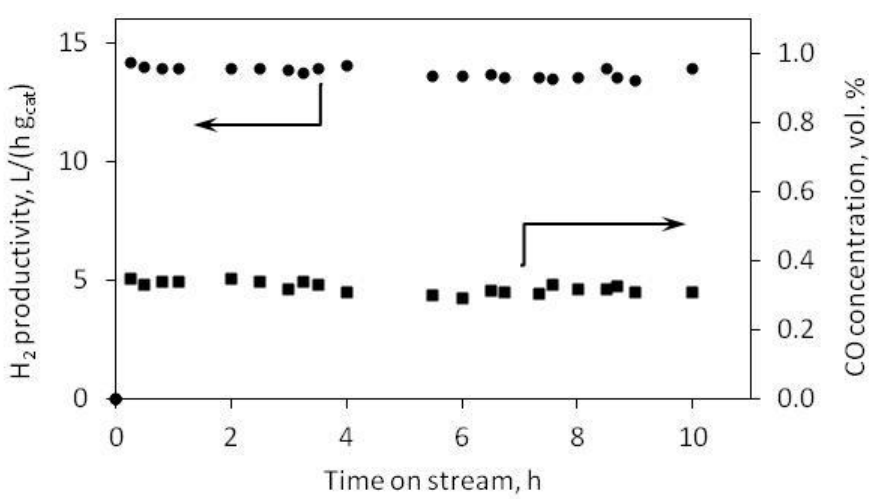
Figure 5. E ff ect of time-on-stream on hydrogen productivity and CO outlet concentrations in DMM oxidative steam reforming (OSR) over CuO-CeO 2 / γ -Al 2 O 3 catalyst. Reaction conditions: P = 1 atm, T = 280 ◦ C, GHSV = 15,000 h − 1 ; Inlet composition, vol.%: DMM:O 2 :H 2 O:N 2 = 10:2.5:40:47.5. Impact of GHSV on the catalytic behavior of the СuO-CeO 2 /γ-Al 2 O 3 in DMM OSR is shown in